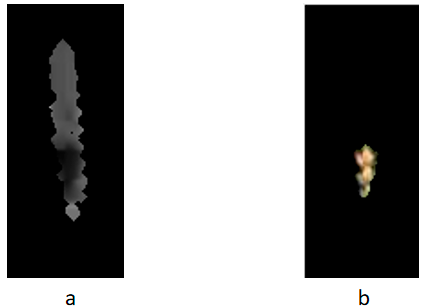
Figure 4. Segmentation of diseased spots. ( a ) The H component map of HSV color space; ( b ) The diseased spot area after segmentation.